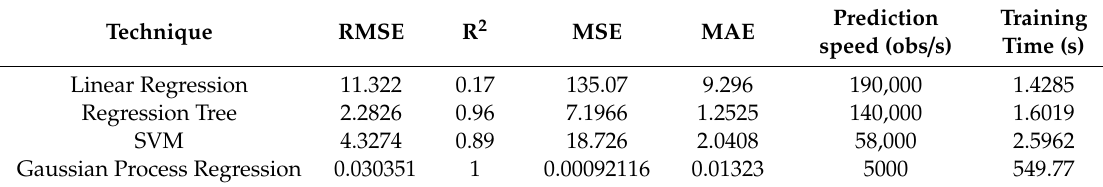
Table 7. Comparison of FTIR validation results with other